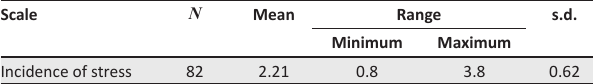
TABLE 7: Mean of nursing students’ incidence of stress.